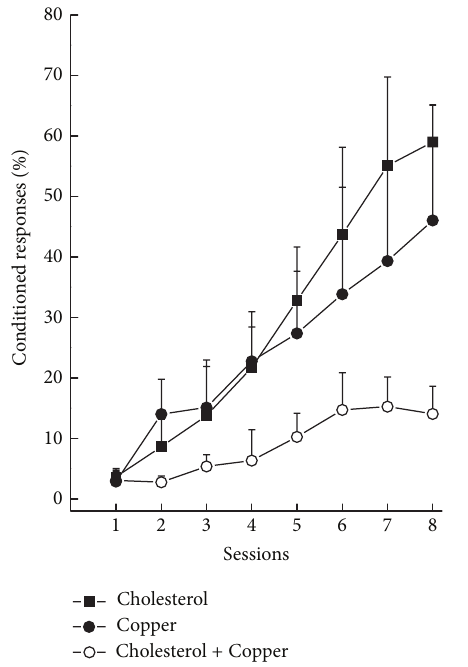
Figure 2: Mean percent ( ± SEM) conditioned responses to a tone conditioned stimulus as a function of eight days of pairings (ses- sions)ofthetoneandairpufftotheeyeforrabbitsfed2%cholesterol in their rabbit chow (Cholesterol), fed normal chow and given 0.12 parts per million copper as copper sulfate in their distilled drinking water (Copper), or fed 2% cholesterol and given 0.12 parts per million copper in their distilled drinking water (Cholesterol + Copper). The data show lower levels of trace conditioning of the nictitating membrane response in rabbits fed cholesterol and given copper in their drinking water. The data are modified from Sparks and Schreurs [46].